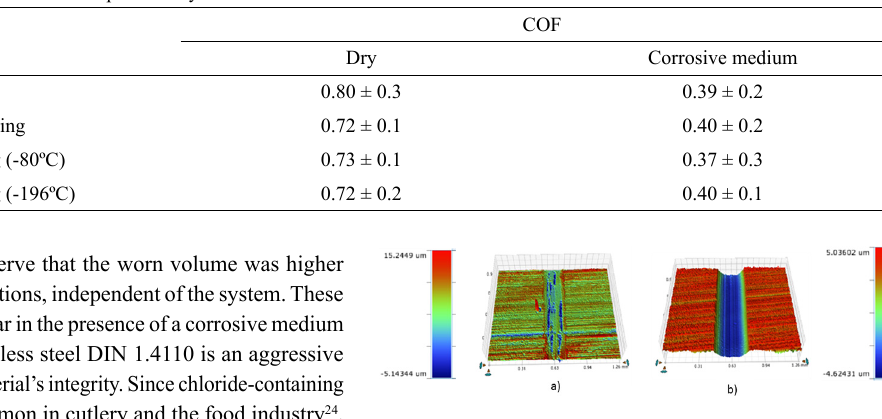
Figure 12: Profilometry results for the cryogenic quenching (-80 °C) sample in a) dry condition and b) corrosive medium.